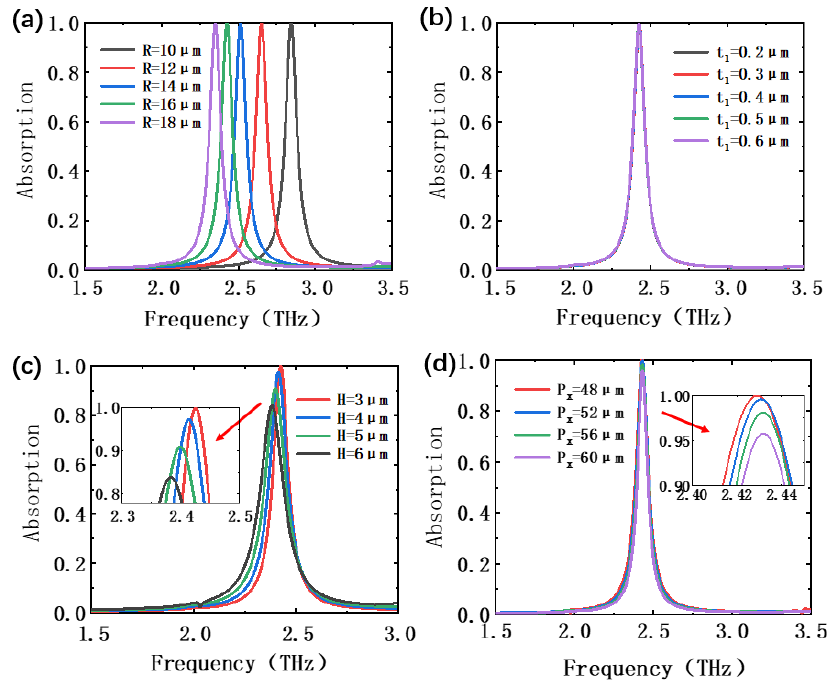
Figure 7. Simulated absorbance spectra for different structural parameters of the proposed PMMA under the environment temperature of T = 280 K: ( a ) the Radius R of the top metal circle, ( b ) the thickness t 1 of the metal layer, ( c ) the thickness H of the intermediate InSb layer, and ( d ) the period length P x = P y of the cell structure.